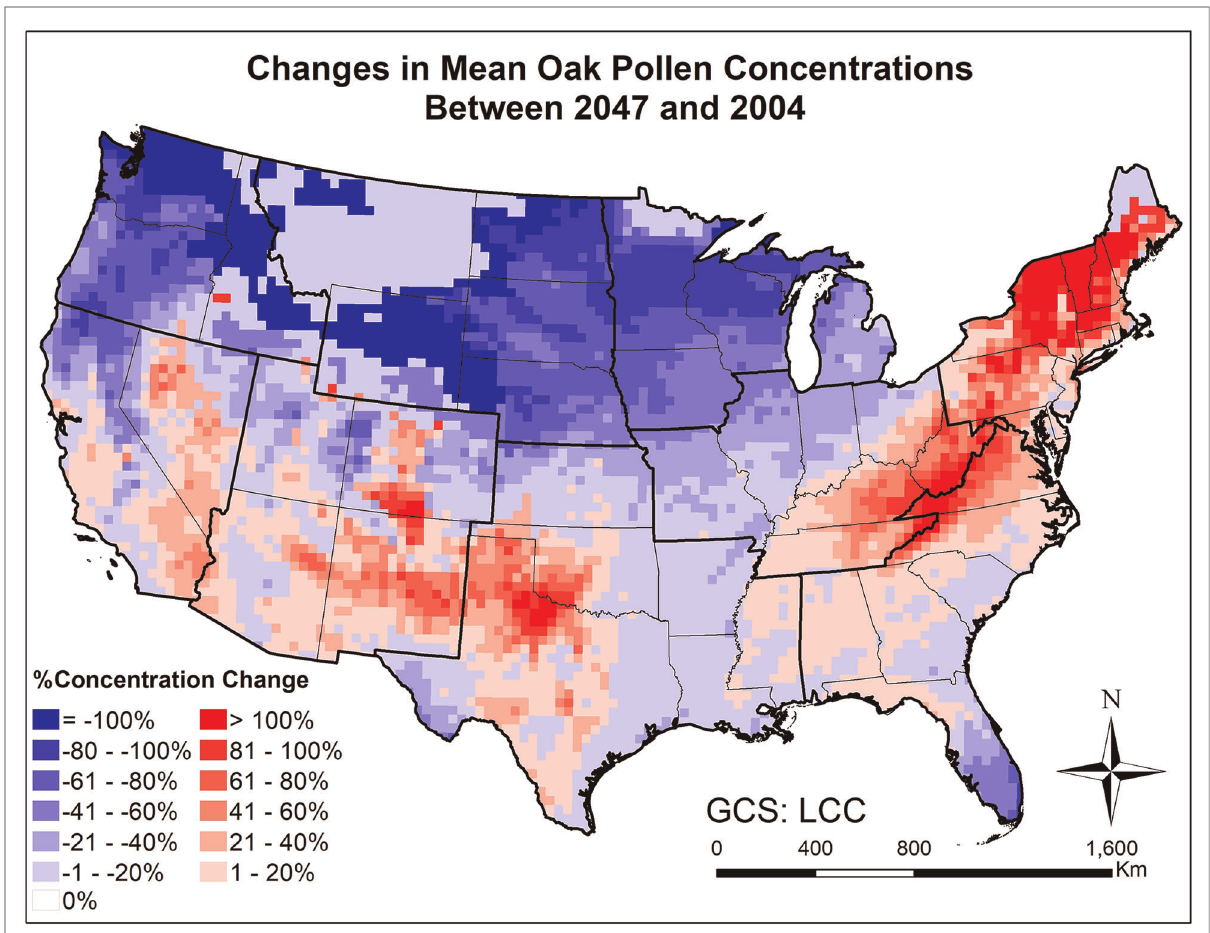
FIGURE 7 Changes in mean March-April oak pollen concentrations from beginning (2004) to mid-21st century (2047) estimated for the RCP8.5 climate change scenario using the CMAQ-Pollen model.